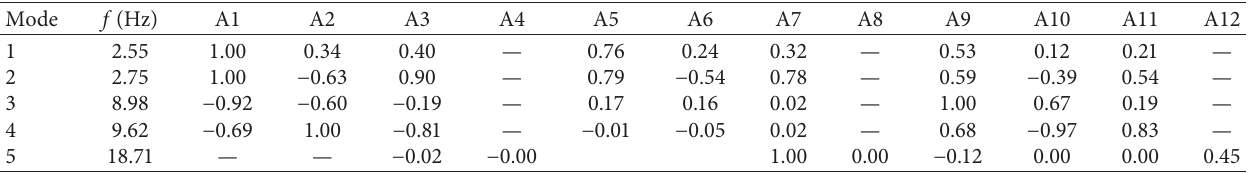
Table 1: Natural vibration modes identified by dynamic tests with the vibration generator in Position #1. Mode